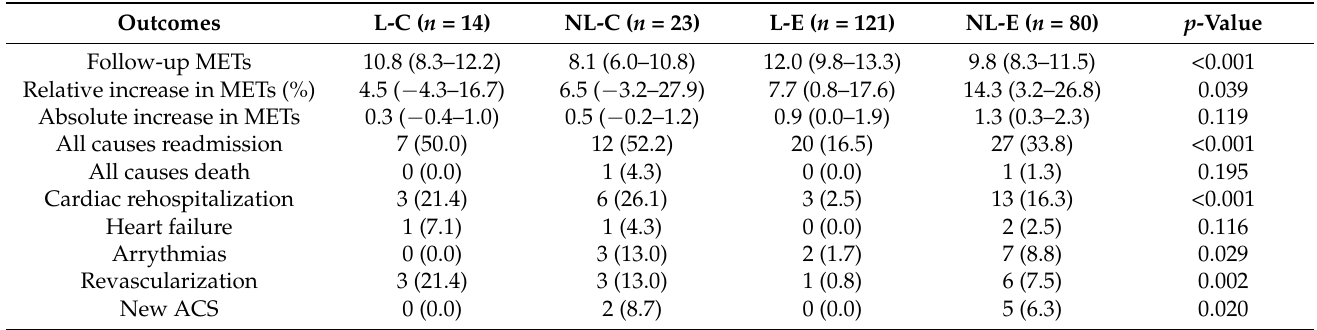
Table 5. Outcomes according to risk stratification and exercise training completion.